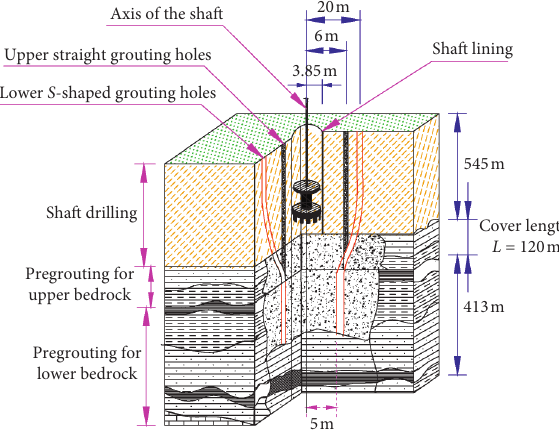
Figure 7: Arrangement of straight holes and s -shaped